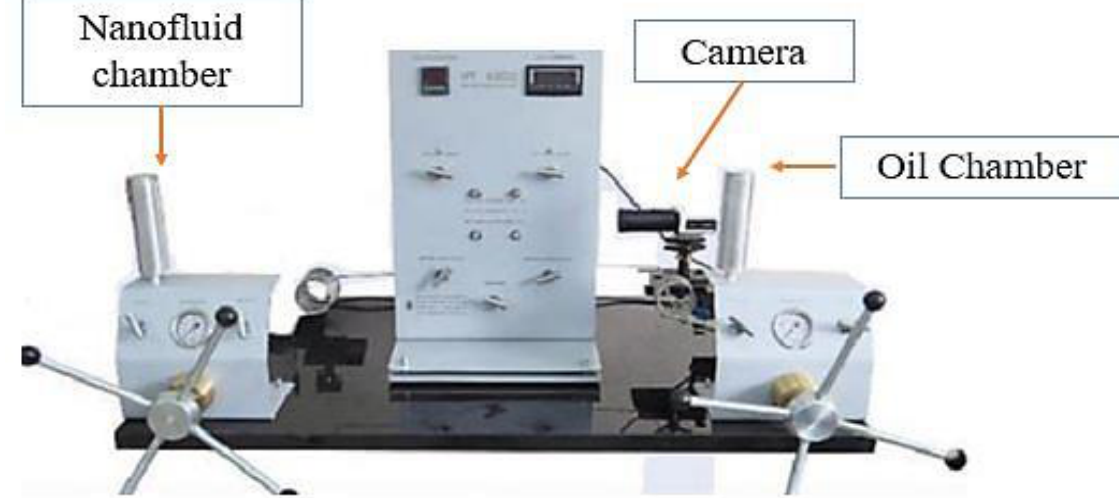
Figure 1. The VIT-6000 apparatus used in this research work for IFT and contact angle measurements. This device used an online image capturing system for recording data under a given pressure and temperature, periodically.